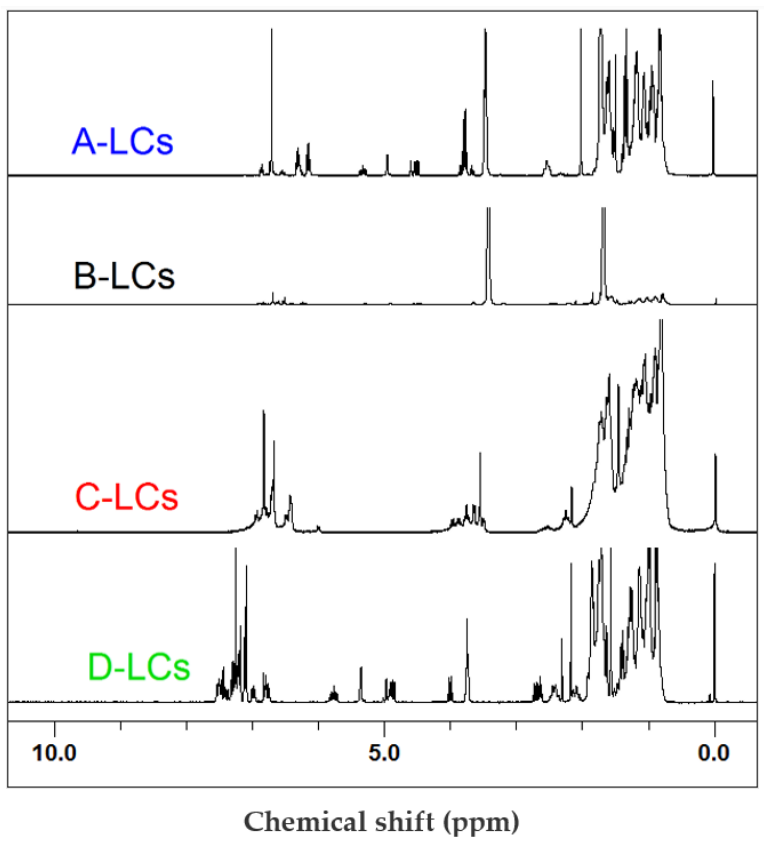
Figure 6. 1 H-NMR results from LC mixtures of EOL-LCD A, B, C and D.